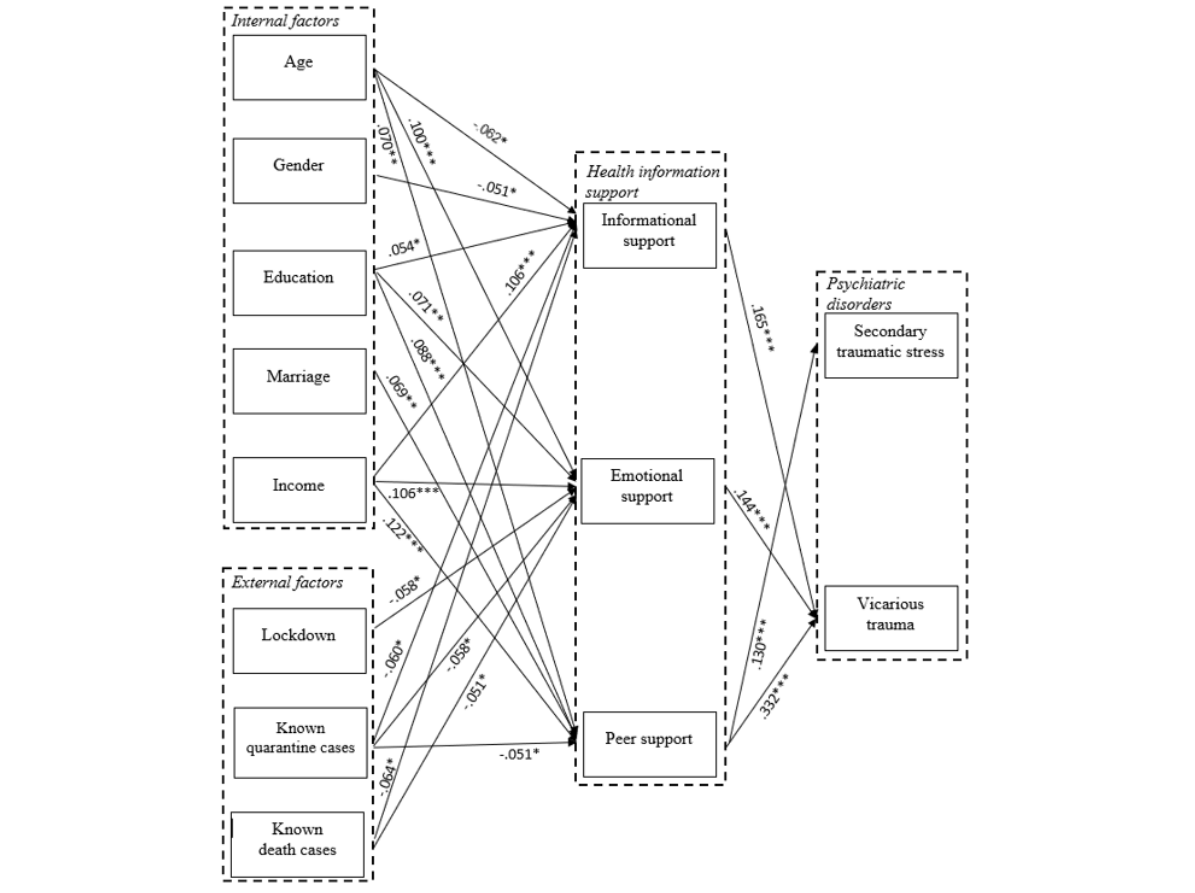
Figure 1. Structural equation modeling to predict secondary traumatic stress and vicarious trauma among participants during the COVID-19 outbreak in